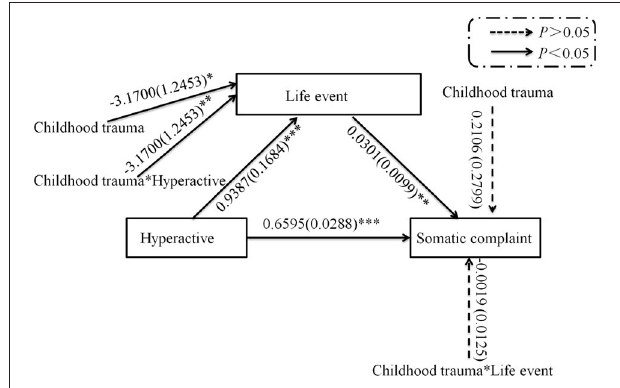
FIGURE 1 | Path of moderation mediation analysis for the relationship between hyperactivity and somatic complaints. * p < 0.05, ** p < 0.01, *** p <